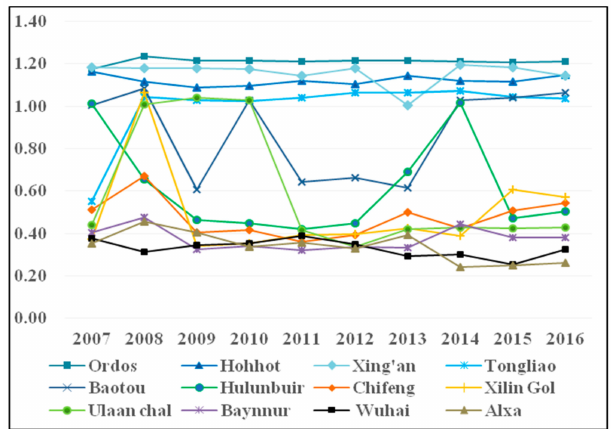
Figure 3. The line chart of the TFP in Inner Mongolia cities from 2007 to